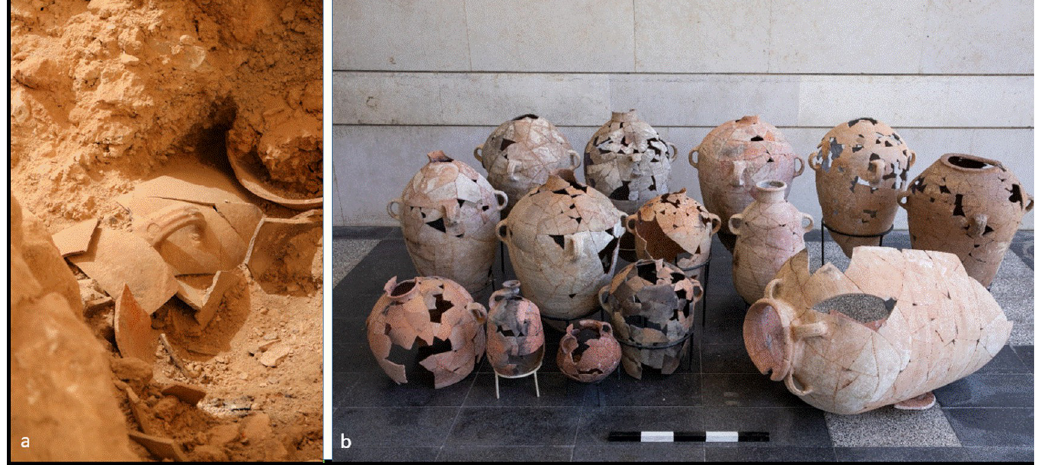
of vanillin. The pithos contained neither wine-markers nor vanillin, but saturated fatty acids of 16–24 carbon atoms and oleic acid and therefore serves as a control, validating the reliability of the results obtained for the storage jars (Figs 4 and S3). Four jars from Structure 17049 underwent the two extraction steps (the others were not analyzed by the wine-markers extrac- tion [WM hereon] due to poor results from the total lipid extraction [TLE hereon]). Two were